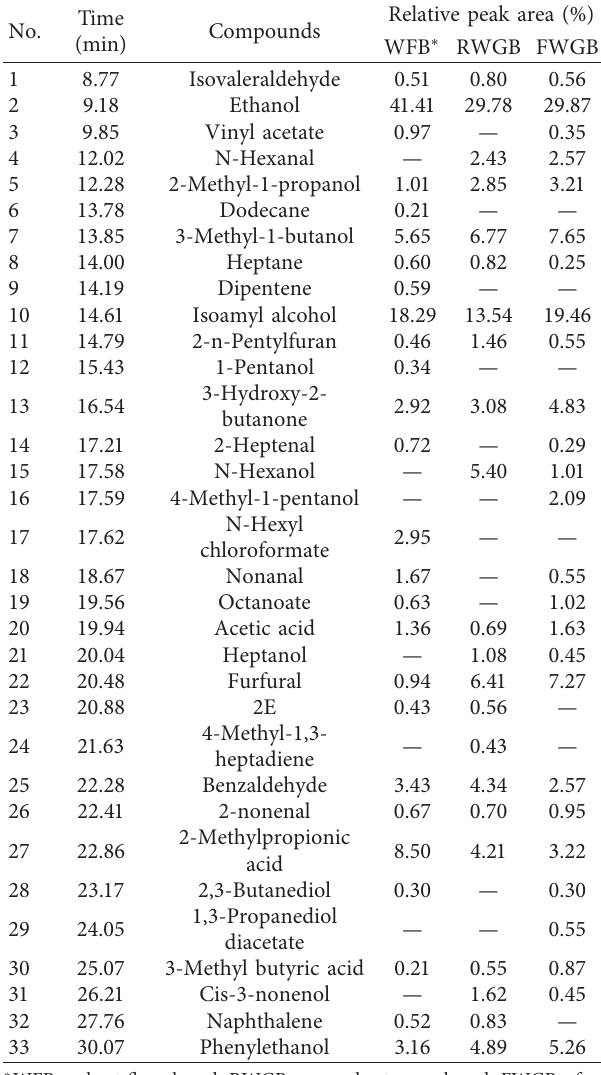
Table 3: The pH value and TTA of bread. Group pH